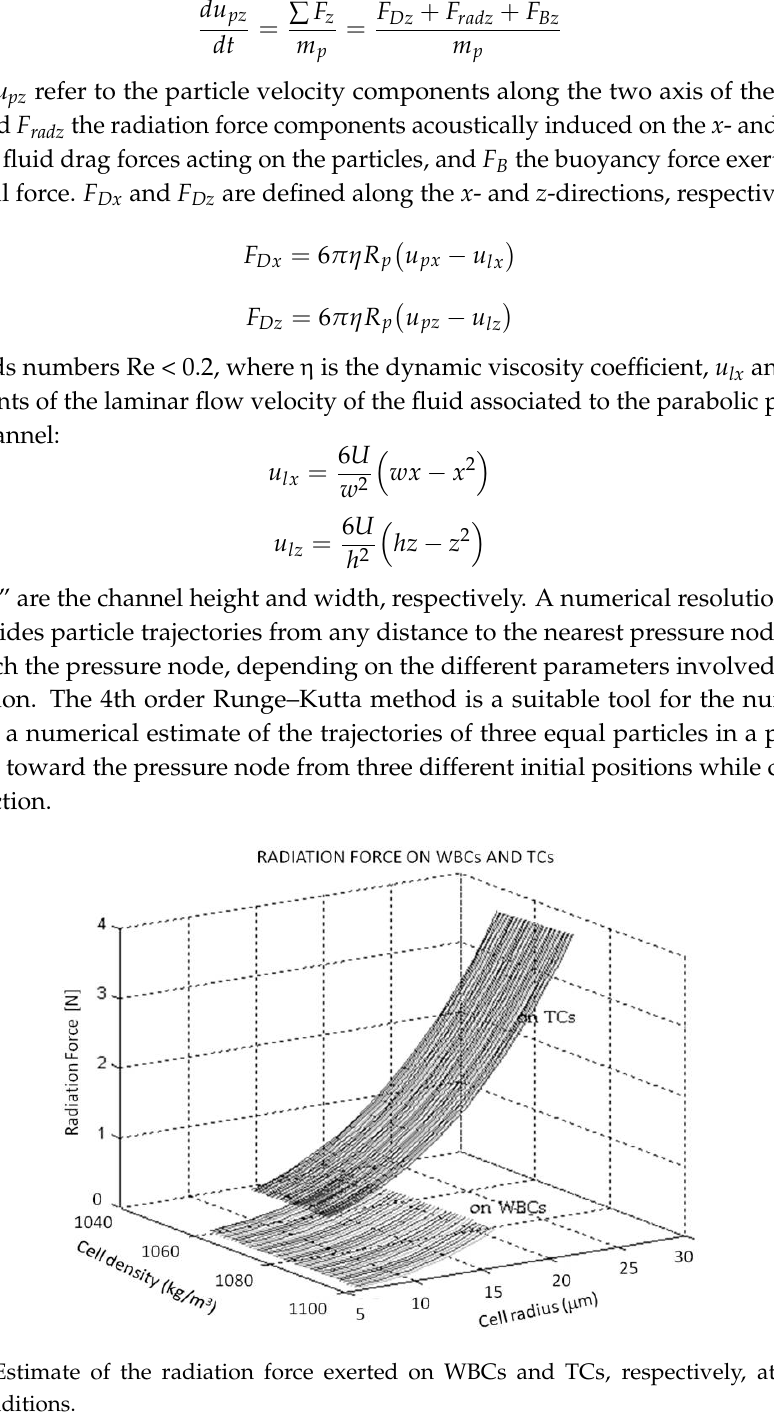
Figure 2. Numerical estimate (Matlab) of trajectories of three equal particles approaching a pressure node from different initial positions while circulating in a transverse direction.